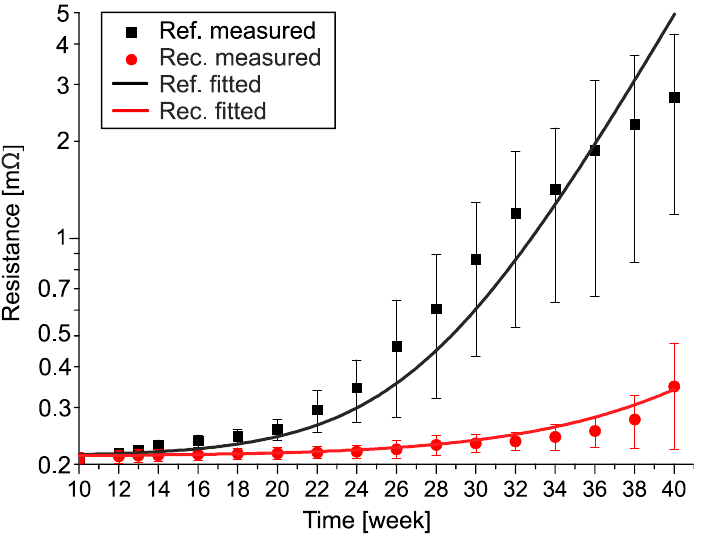
Figure 4. Plot of the electrical resistance changes in the reference (black) and recrystallized (red) samples at − 10 °C, showing measured average (dots), and fitted curves.